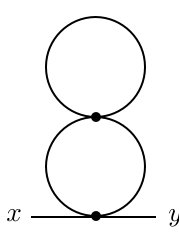
Figure 2 . Feynman graph giving a subleading two-loop ‘cactus’ correction to the scalar propagator. Although this is not the only two-loop contribution, it is noteworthy because of the power-law (as opposed to logarithmic) IR divergences it acquires due to the singularity of the Bose-Einstein distribution at small